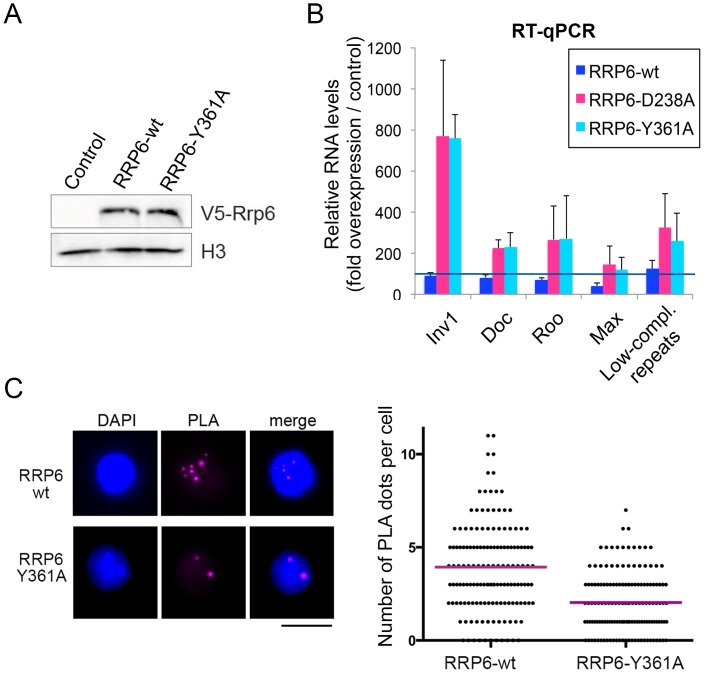
The catalytic activity of RRP6 is required for the silencing of transposon transcripts and for the maintenance of heterochromatin compaction.Wild-type RRP6-V5 or catalytically inactive mutants RRP6-Y361A-V5 and RRp6-D328A-V5 were expressed in S2 cells. Control cells that did not overexpress any protein were used in parallel for comparison. (A) Analysis of protein expression by Western blotting using an antibody against the V5 tag. Histone H3 served as loading control. (B) RT-qPCR analysis of transcript levels in cells that overexpress wither the wild-type RRP6-V5 or the catalytically inactive mutants. RNA was isolated and analyzed using primer pairs designed to amplify selected sequences, as indicated in the figure. The data was normalised to actin 5C mRNA levels and expressed as a fold change compared to the levels observed in the control cells (dark blue line). The histogram shows averages and standard deviations from three independent biological replicates. (C) PLA analysis of chromatin compaction using antibodies against HP1a and histone H3. The images show examples of PLA staining (magenta) in cells counterstained with DAPI (blue). The graph shows the number of PLA dots per cell in each condition. The mean number of dots per cell (magenta line) was 3,93 in the cells that overexpressed wild-type RRP6-V6 and 2,04 in cells that overexpressed RRP6-Y361A-V5. The difference was highly significant (P<0.0001; two-tailed Mann Whitney test; n = 150 cells analyzed in each condition, from two independent experiments).